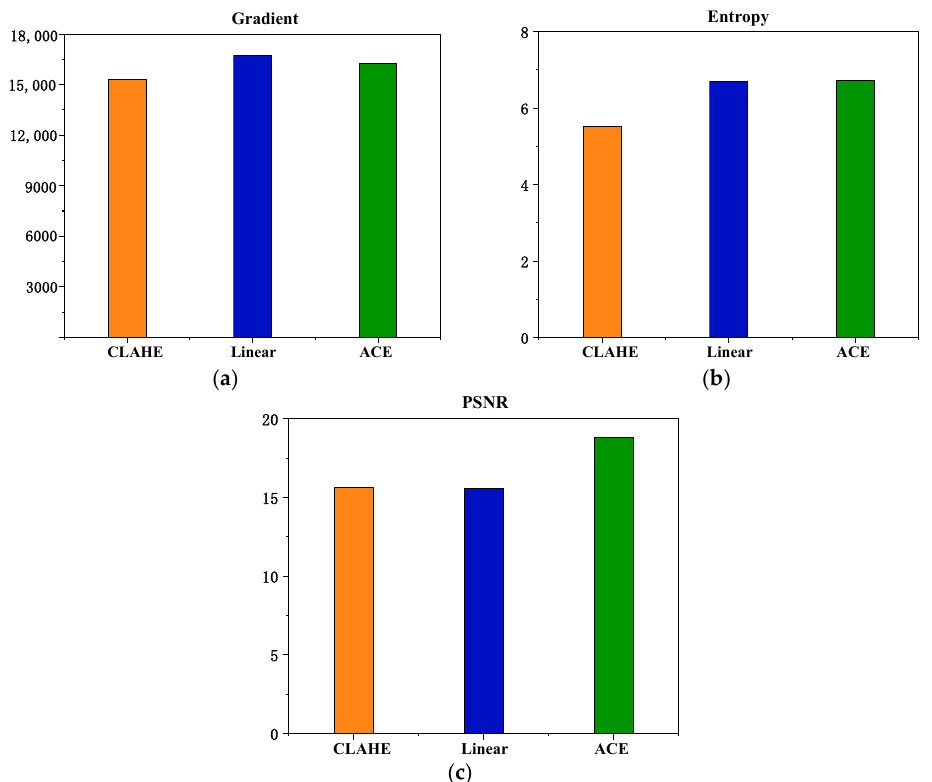
Figure 5. Comparison of three data augmentation algorithms. ( a ) Gradient; ( b ) entropy; ( c ) PSNR.